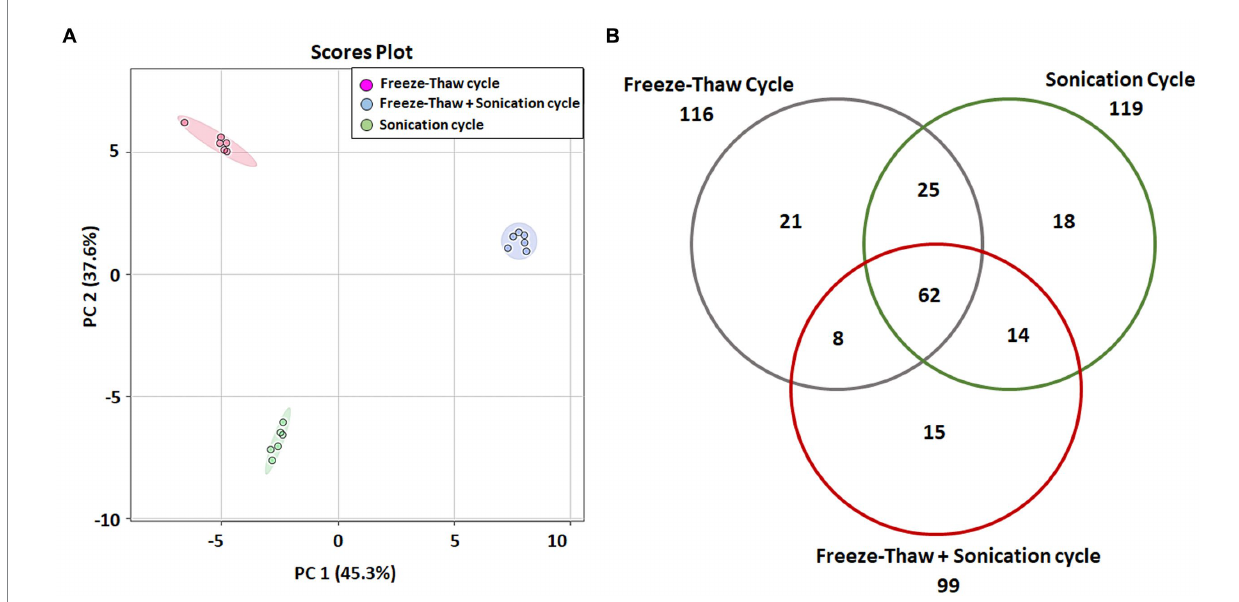
FIGURE 1 Multi-variate analysis of identified metabolites. (A) Principal component analysis (PCA) showing score plots of the metabolic differences between 3 methods (consisting a total 6 independent biological replicates for each method), red: freeze-thaw Cycle (FTC), green: Sonication Cycle (SC), blue: freeze-thaw Cycle followed by Sonication Cycle (FTC + SC). All three methods clustered distinctly having replicates of each method together indicating the consistency of sample preparation and downstream analysis. (B) Venn diagram representing unique and common metabolites among the three different methods of metabolite extraction [freeze-thaw cycle (FTC), Sonication Cycle (SC) and freeze-thaw cycle followed by Sonication Cycle (FTC + SC)]. A total of 62 metabolites were common among all 3 methods, whereas 21, 18, and 15 were uniquely identified in FTC, SC, and FTC + SC, respectively, indicating the potential biasness of the individual methods. Data from n ≥ 4 (out of six independent biological replicates were used in this analysis). One-way ANOVA was used to select the significant metabolites, i.e., 163 total metabolites (cutoff value of p ≤ 0.05) for the